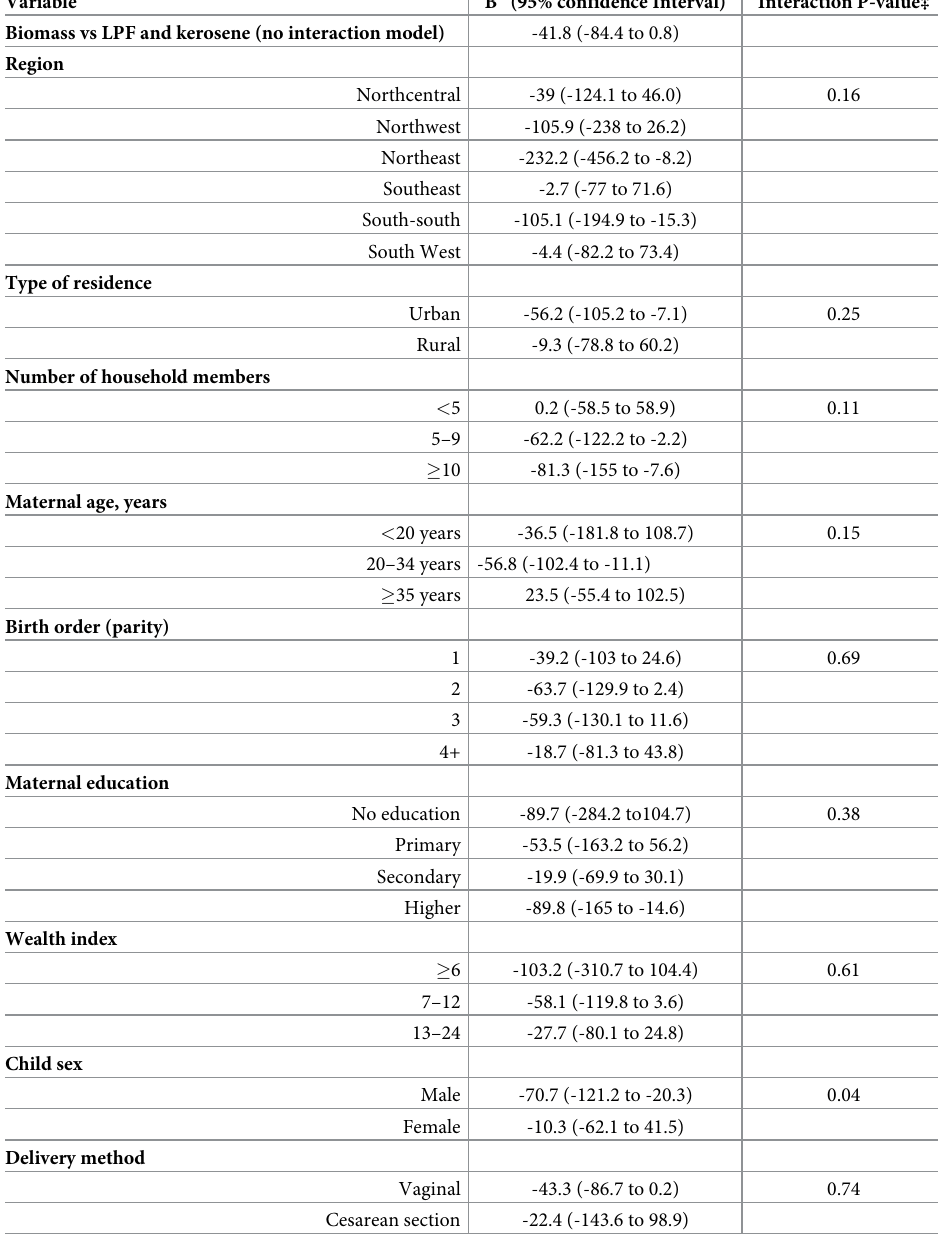
Table 6. Associations between biomass fuel and birth weight by levels of other factors in the 2018 Nigeria Demo- graphic and Health Survey (N =